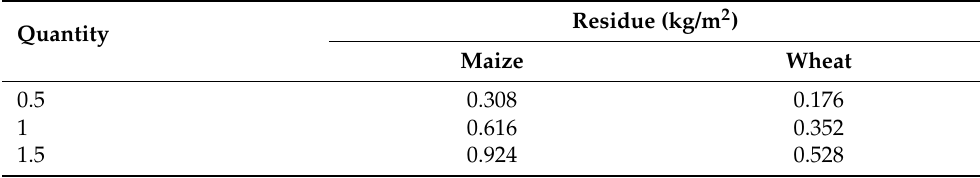
Table 1. Quantities of maize and wheat residues used for the